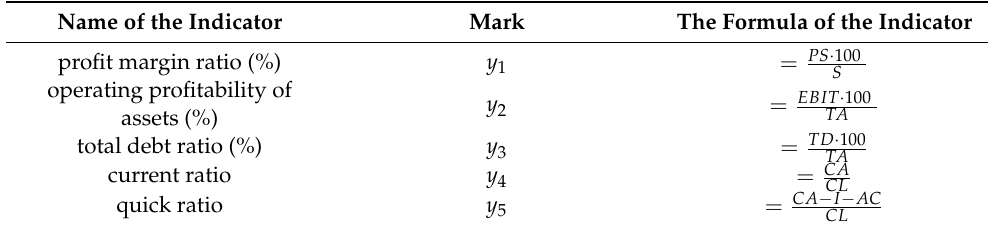
Figure 5. Profit margin ratio ( y 1 ) in the enterprise and in the sector in 2017–2020 (%). The obtained results, in comparison with the values achieved in the entire sector, indicate that the studied company achieved relatively low profitability in the year 2018. The average profitability in the sector at that time was 6.2%. It is worth noting that profit ‐ ability of entities in the sector was considerably varied. In the year 2018 the profit margin ranged from − 56% to 78%, and operating profitability of assets ranged from − 55% to 75% (Figures 5 and 6). This means that the surveyed company, despite the implementation of a strategy for the development of production activities, the main directions of which were the improvement of the quality of the mushroom organic cover (main product), and the restructuring of the management of production, sales, and communication with contrac ‐ tors, ranks among the companies with a poor financial condition. This conclusion was confirmed by results obtained in the years 2019 and 2020. A total debt ratio ( y 3 ) was also calculated for this case and shows the company’s abil ‐ ity to pay back debt and helps assess financial risk [58]. The debt ratio represents a meas ‐ ure of the company’s ability to pay back loans and the attached interest obligations when due. It also helps in assessing the financial risk of a company [59]. The values of this ratio indicate a very high level of foreign capital in the company. The total debt ratio ( y 3 ) ranged from 84% in 2018 to 98% in 2019. This high value of the ratio indicates a poor financial condition and significant financial risk. It means that if the situation will not improve it could result in the shutting down of the company, with the consequent stoppage of peat extraction, halting of the construction of the reservoir and a loss of jobs. The financial problems, including the high risk of doing business, were confirmed by the difficult situation around the ability to repay current liabilities. The current and quick